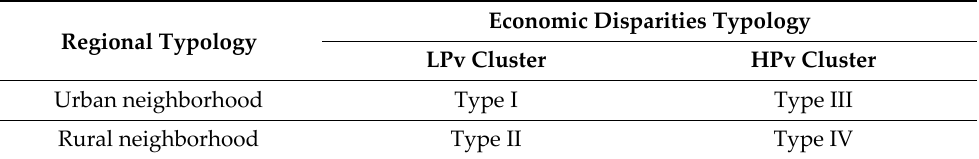
Table 2. Criteria for determining types of neighborhoods in the regional economic disparities’